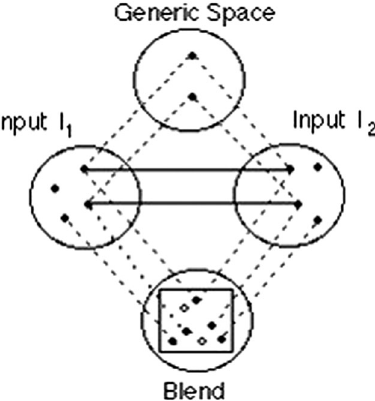
FIG. 1. Schematic representation of a blending diagram from the original work of Fauconnier and Turner